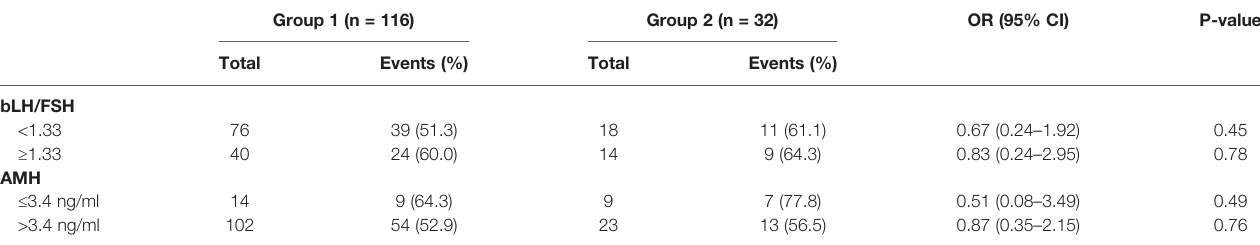
TABLE 4 | A subgroup analysis of the clinical pregnancy